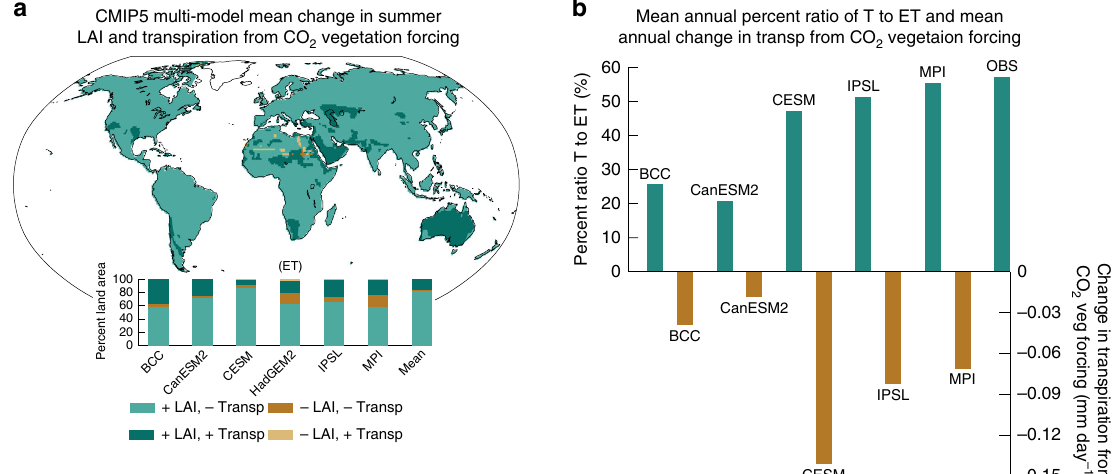
Fig. 2 Changes in leaf area index and transpiration from CO 2 vegetation forcing. a Map of summer leaf area index (LAI) and transpiration changes of a particular direction for the CMIP5 multi-model mean. Bar plots of the percentage of land area with LAI and transpiration changes of a particular direction. b (top) Global mean annual percent ratio of transpiration to evapotranspiration (T to ET) from the CMIP5 models and from observations provided in Wei et al. (2017). b (bottom) Global mean annual change in transpiration in the CMIP5 models from CO 2 vegetation forcing. The values for the ratio of T to ET come from years 18 – 34 (CO 2 ~ 340 – 398 ppm) in each model ’ s TotalCO2 simulation. Years 18 – 34 are chosen to closely match the CO 2 values during the years 1982 – 2014, which are used in Wei et al. (2017). Area-weighted averages are calculated from 60°S – 90°N and do not include Greenland. June – September (December – March) values are used in the Northern (Southern) Hemisphere. Evapotranspiration (ET) is used for